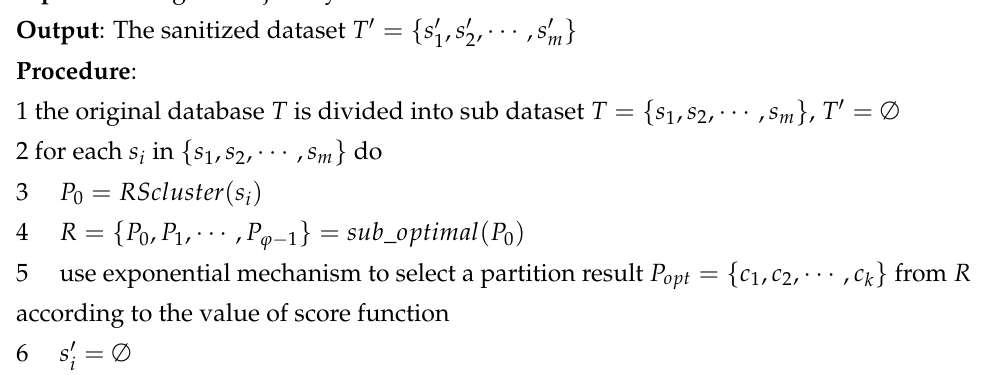
Algorithm 1 trajectory privacy protection method based on random sampling differential privacy